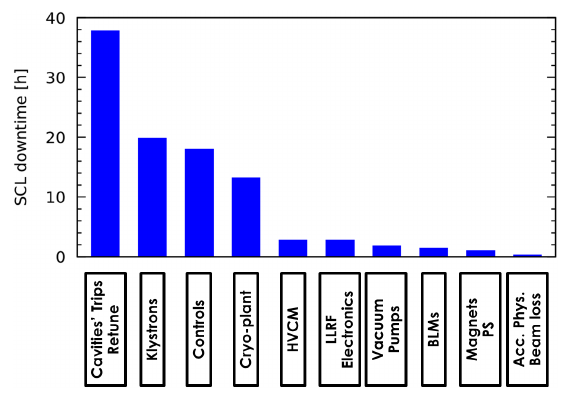
FIG. 5. Break down of the SCL downtime in FY20 by the subsystem of its origin.